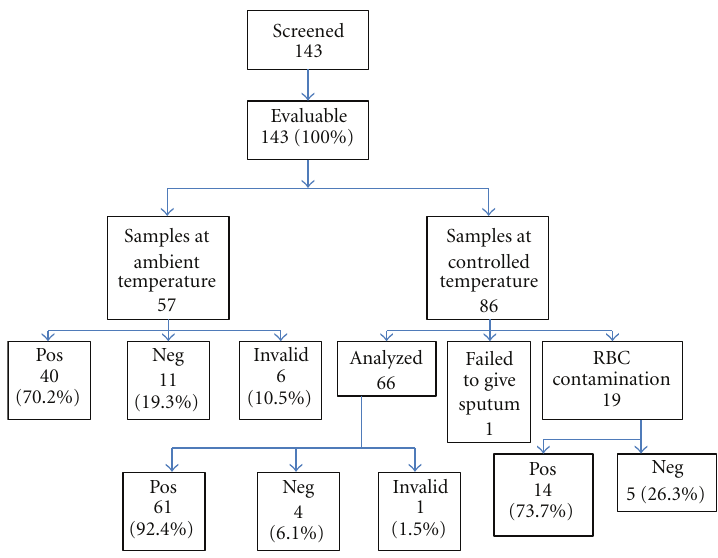
Figure 1: Patient flow and testing results using T-SPOT. TB and T Cell Xtend, Dar es Salaam, Tanzania.